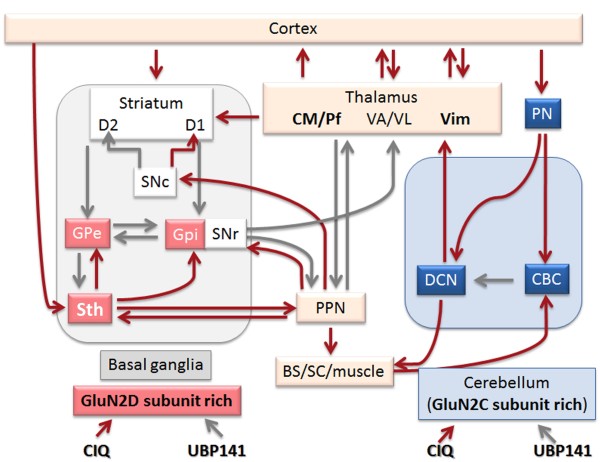
The basal ganglia and cerebellum are involved in motor control. Both circuitries receive projections from the cerebral cortex and send signals to the thalamus. These signals are then accumulated in the cerebral cortex. The inhibitory regulation from the basal ganglia and stimulatory regulation from the cerebellum modulate the activity of the cerebral cortex. UBP141 inhibited the NR2C subunit in both WT and GluN2D KO mice but only inhibited the NR2D subunit in WT mice. Thus, the inhibition of the GluN2D subunit is a more important factor for motor impairment than the inhibition of the GluN2C subunit. Similarly, CIQ potentiated the function of the GluN2C/2D subunit of the NMDA receptor in WT mice but potentiated only the GluN2C subunit in GluN2D KO mice. The potentiation of both the GluN2C and GluN2D subunits did not induce motor impairment in WT mice but induced motor impairment in GluN2D KO mice. Based on the balance between two competing forces, goal-directed movements could be appropriately performed. Figure is modified from [16]. Red arrows indicate excitatory pathways; gray arrows indicate inhibitory pathways. BS/SC, brain stem/spinal cord; CBC, cerebellar cortex; CM, centromedian nucleus of the thalamus; DCN, deep cerebellar nuclei; GPe, globus pallidus external segment; GPi, globus pallidus internal segment; Pf, parafascicular nucleus of the thalamus; PN, pontine nucleus; PPN, pedunculopontine nucleus; SNr, substantia nigra pars reticulate; SNc, substantia nigra pars compacta; Sth, subthalamic nucleus; VA, ventral anterior nucleus of the thalamus; Vim, ventral intermediate nucleus of the thalamus; VL, ventrolateral nucleus of the thalamus.